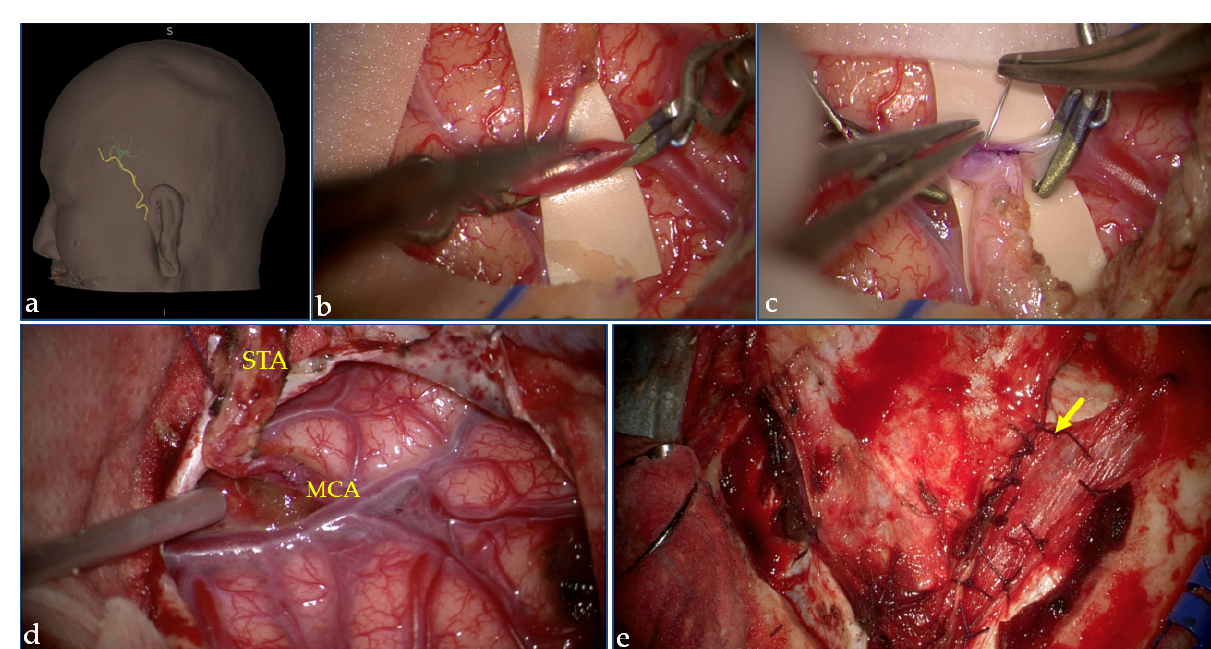
Figure 3. Direct and indirect revascularization surgery. During surgery, a three-dimensional rendering obtained by CT angiography ( a ) shows the course of STA (in yellow) and of the peripheral branches of MCA (green) on the left hemisphere in a patient who underwent combined revascularization surgery. The intraoperative pictures acquired under microscopic view depict the different phases of surgical procedure: in ( b ), temporary clips are positioned in the M4 branch. Then, the STA-MCA bypass is performed with interrupted suture ( c ). After the bypass is completed ( d ), the encephaloduromyosynangiosis with dura and temporal muscle (arrow) is then performed ( e ). (Procedure performed at the Neurosurgery Department, Fondazione IRCCS Istituto Neurologico Carlo Besta, Milan; pictures are reproduced with patient’s permission).